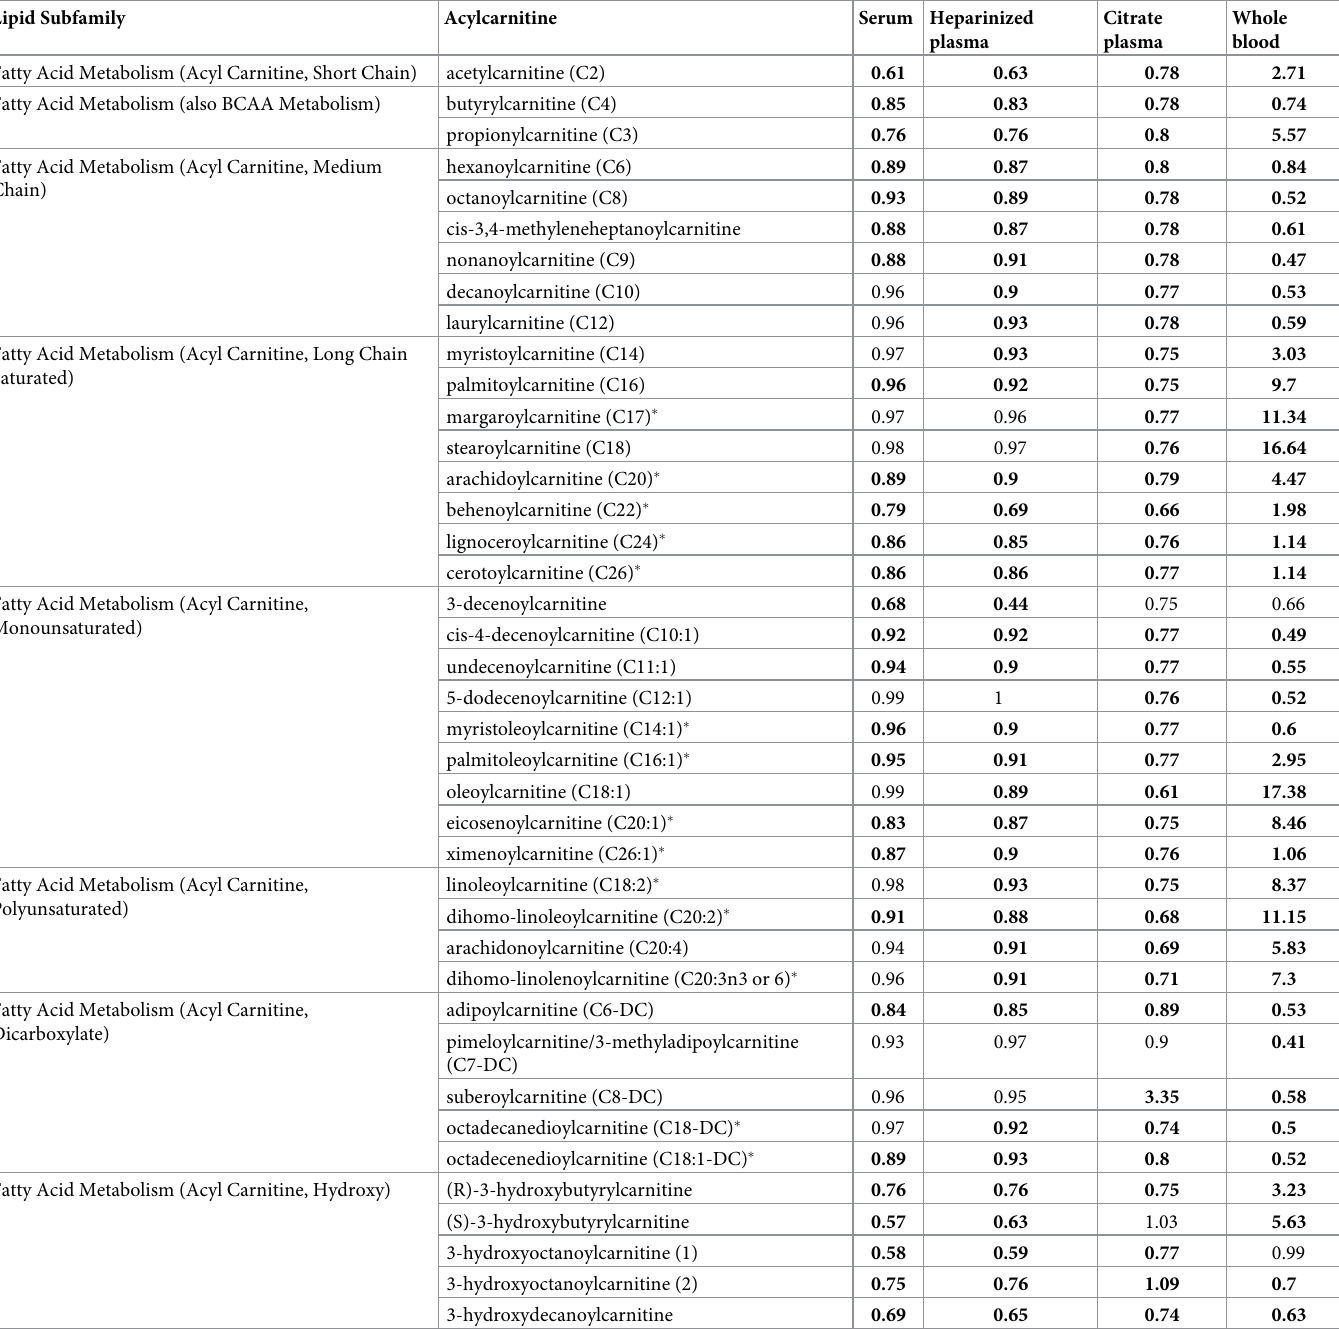
Table 3. Fold-of-change in acylcarnitine levels in the blood specimens versus EDTA plasma. Lipid